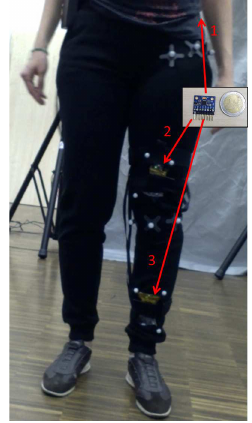
Figure 7: Real test setup. The red arrows show three IMUs which are mounted on pelvis (1, not visible), upper leg (2) and lower leg